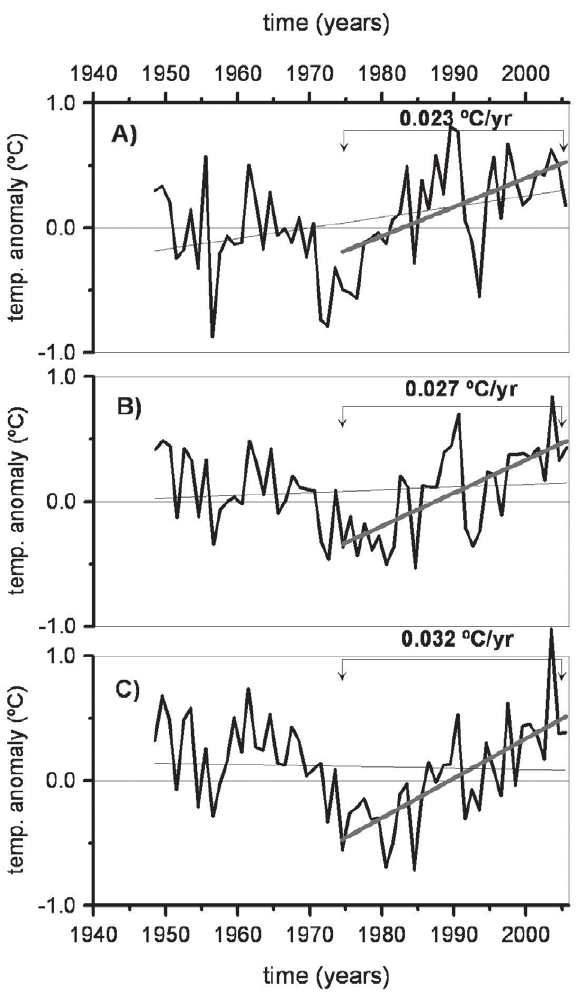
Fig . 12. – sea surface temperature anomalies from the nceP. a, alboran sea, b, balearic sea, and c, northern sector. The thick line is the linear trend for the period 1974-2005. The corresponding fig- ure is inserted for comparison with salat and Pascual (2002, 2006). The thin black line is the linear trend for the period 1950-2005, for comparison with Krahmann and schott